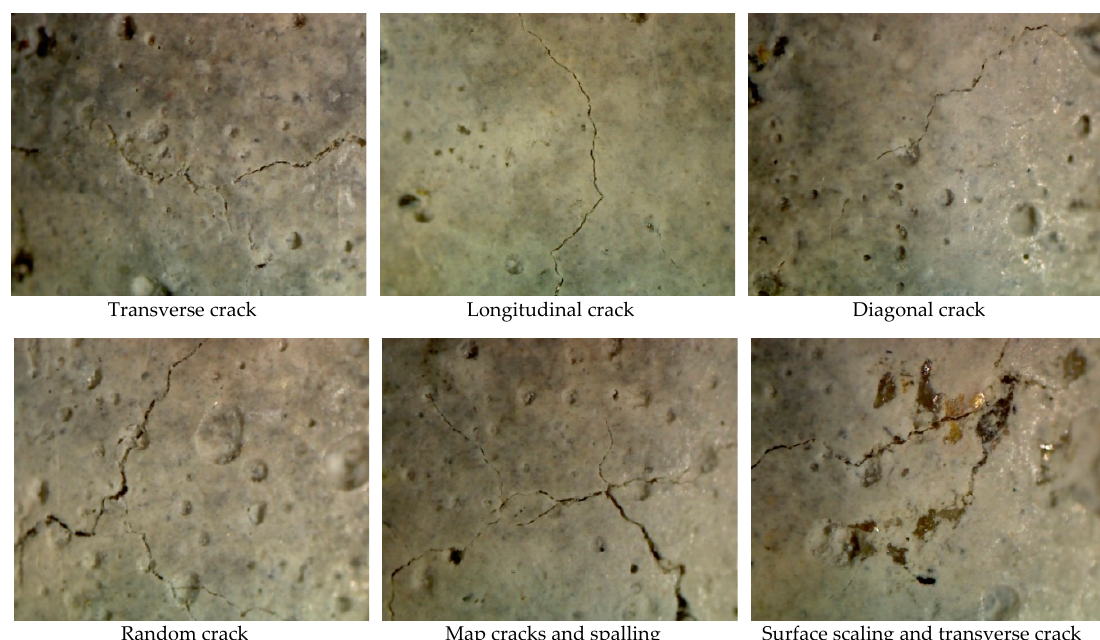
Figure 10. A representative view of cracks formed on the surface of 12% OPC mortars observed under a light microscope after 84 days of immersion in Na 2 SO 4 solution at 25 °C.